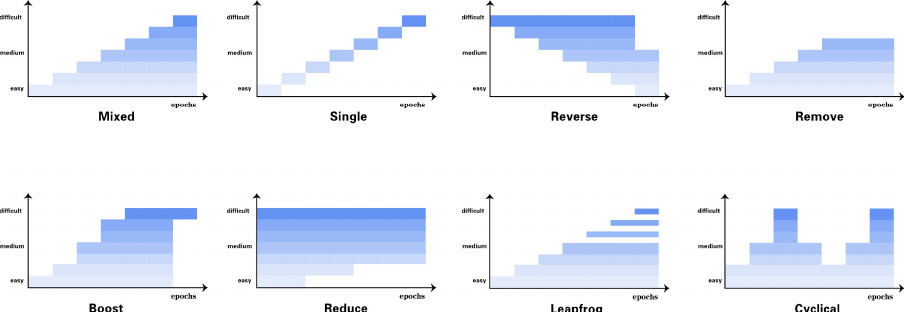
Figure 10. Visualization of a training scheduler based on shards. The horizontal axis indicates the number of epochs, and the vertical axis indicates the difficulty of the sample.